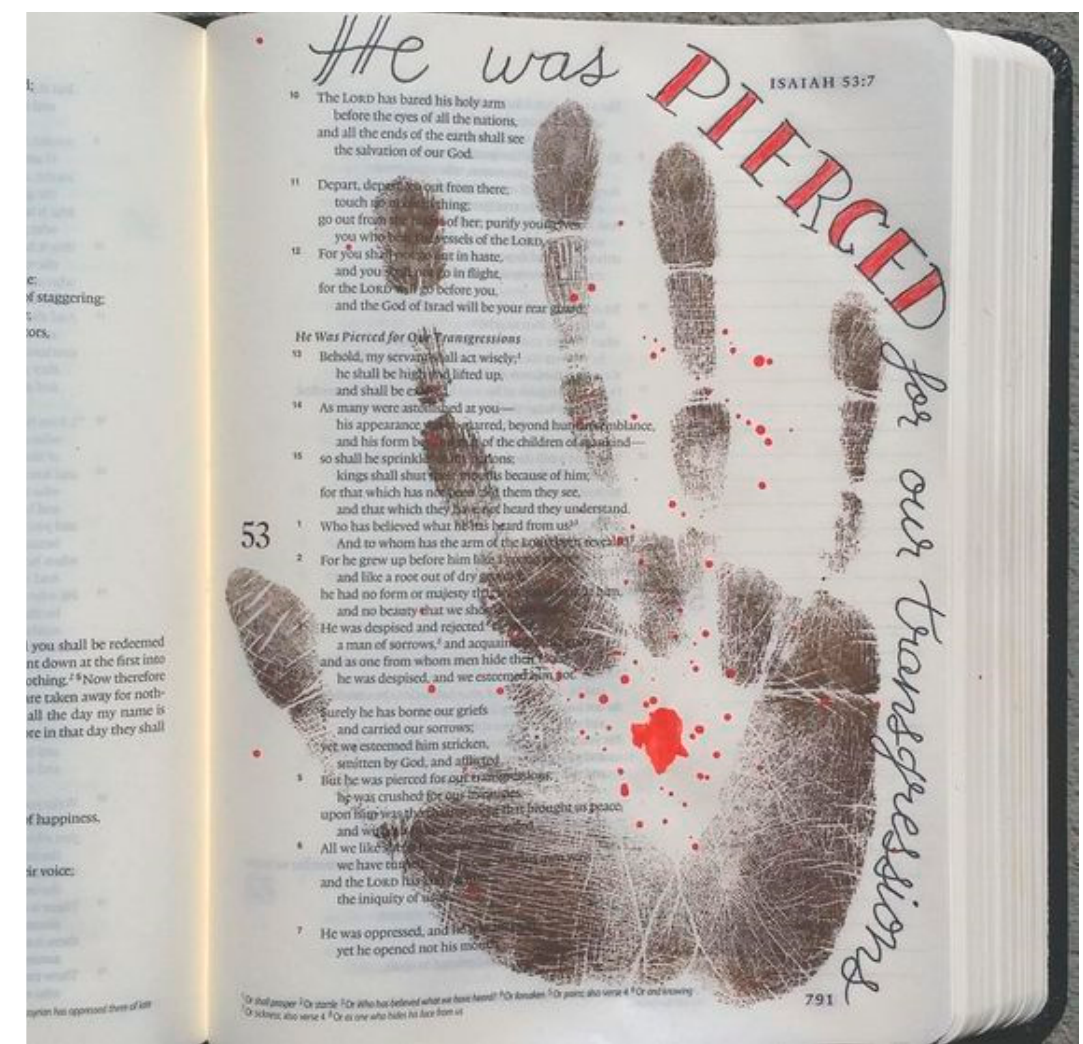
Figure 2. “He was Pierced for Our Transgressions” (2018) by Peggy Buckley Thibodeau (with kind permission of the journaler).